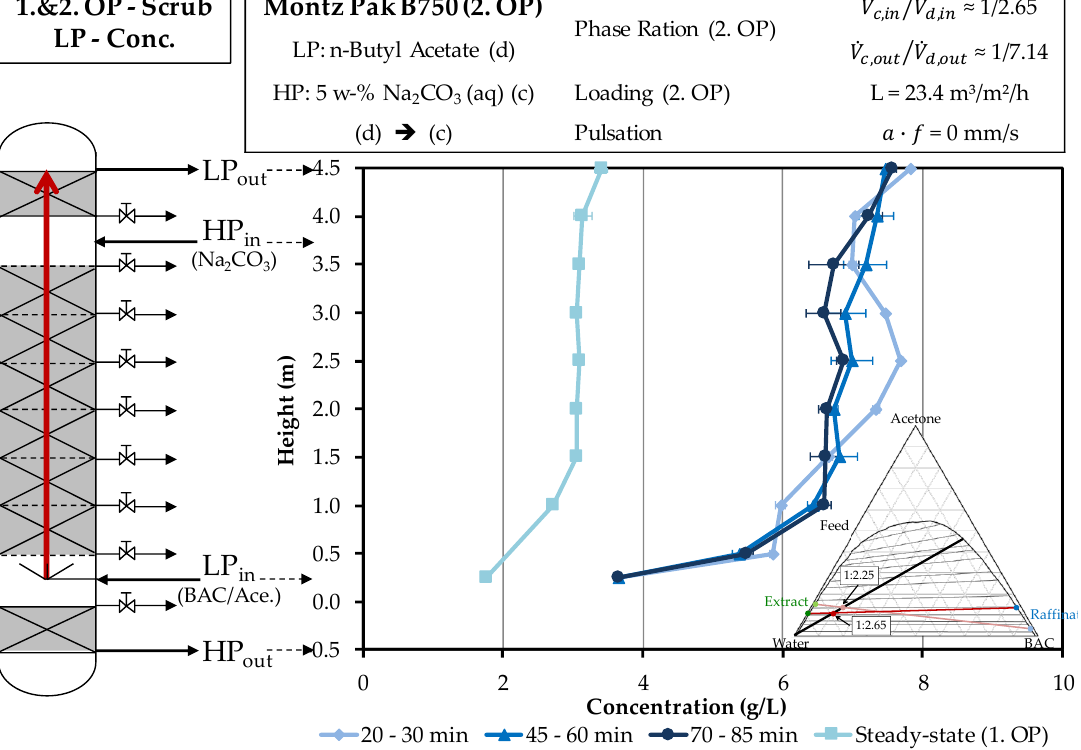
Figure 10. Comparison of the concentration profiles of artemisinin across the column height of the light phase in the experimental progression of the first and second operating points of scrubbing. Concentrations are obtained by HPLC. OP (operating point), BAC (butyl acetate), Conc. (concentration).